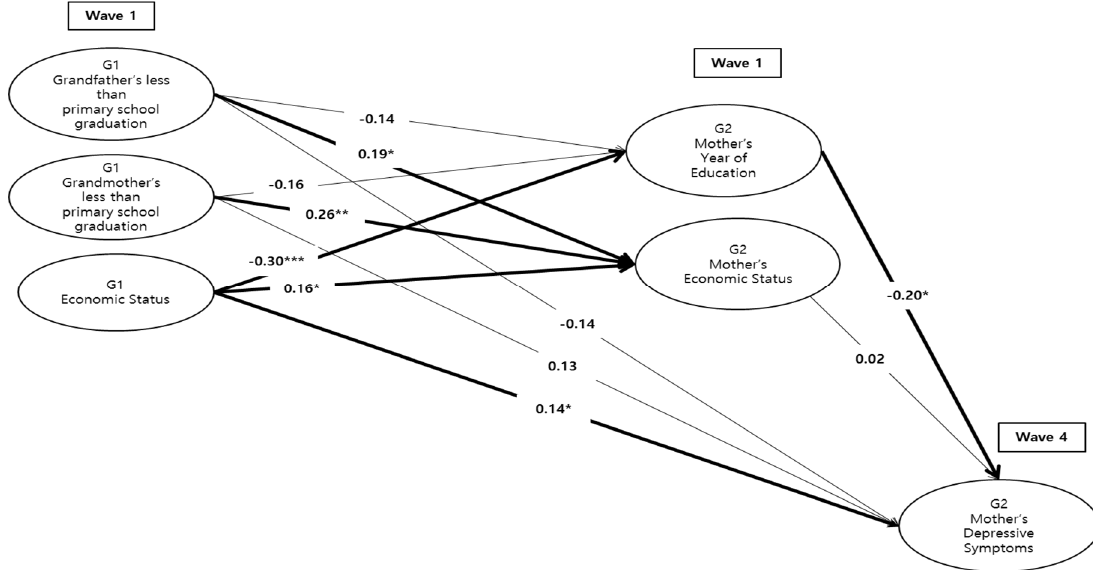
Figure 1. Standardized results of intergenerational model by mother’s years of education (G2) and economic status (G2) as mediators. The model above controls mother’s demographic factors such as mother’s age, mother’s living with spouse, mother’s number of siblings, mother’s family income, and mother’s employment. The thick line in the figure indicates statistical significance. * p < 0.05, ** p < 0.01, *** p < 0.001.